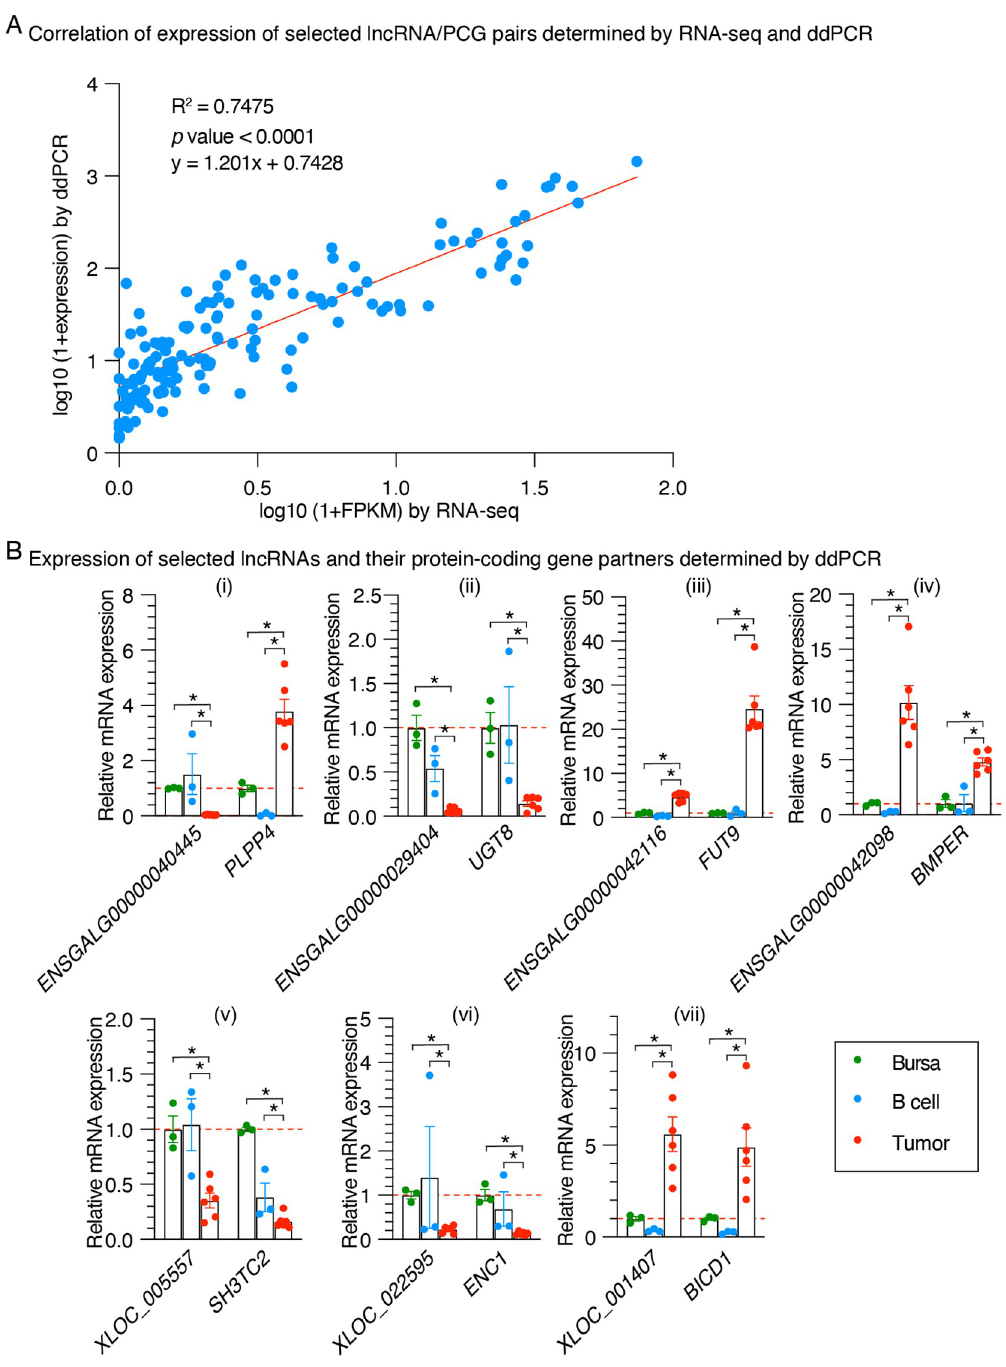
Fig 7. Validation of RNA-seq results by ddPCR. (A) Correlation analysis indicating that the expression levels of the 7 selected lncRNA/protein-coding gene pairs identified by RNA-seq and ddPCR were significantly positively correlated with a R 2 = 0.7475 and p value < 0.0001. (B) The abundance of the selected lncRNAs and their protein-coding gene partners in individual samples from each of the bursa (n = 3), B cell (n = 3) and the LL-like tumor (n = 3) groups were confirmed by ddPCR ( � p < 0.05 in an un-paired t